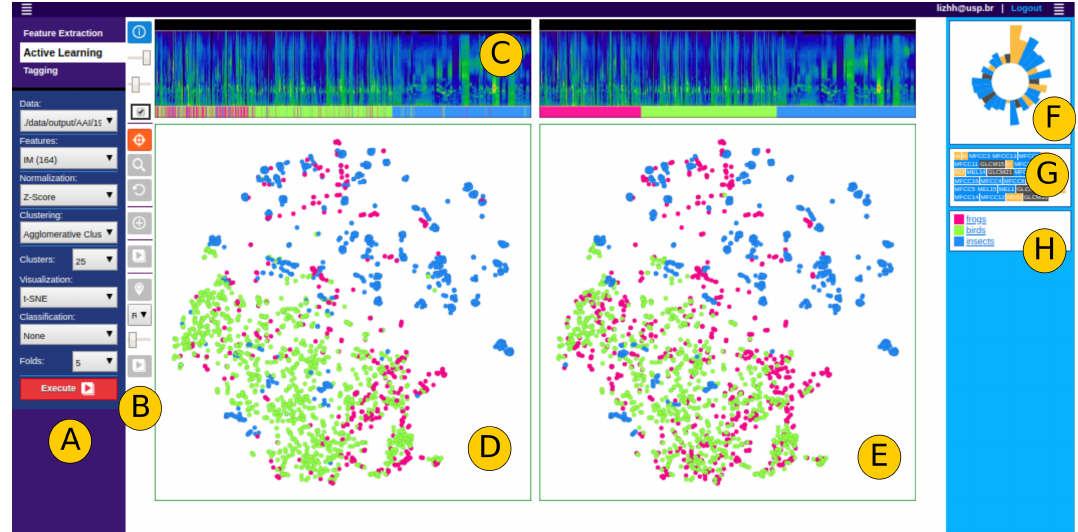
Figure A1. Screenshot of the main interface of the Framework . (A) Initially, a configuration parameter panel (B) Allows interact and explore the data within the projection in region D. (C) TLS is coordinated with the projection’s data, allowing exploration interactive. (D) Multiple visualizations of the active learning process. (E) The ground truth. (F) Polar histogram of features. (G) Features used in the experiment. (H) Legend of labels in the data